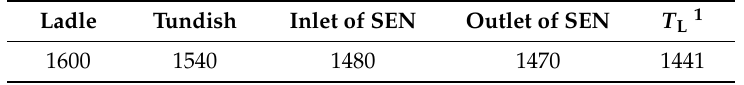
Figure 4. Precipitation of Ti-oxides in 321 stainless steel. Table 2. Typical processing temperatures during the casting of 321 stainless steel, °C.